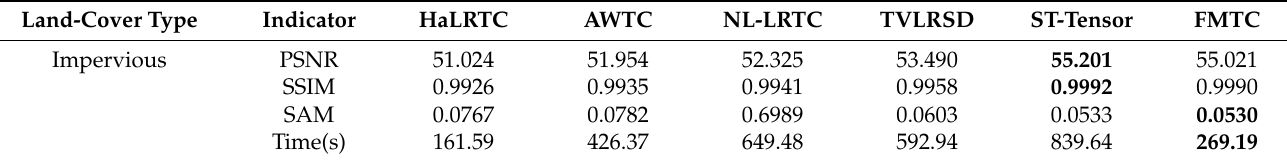
Figure 12. Enhanced details from Figure 11a–h: ( a ) original image; ( b ) simulated cloudy image; ( c – h ) reconstructed images of HaLRTC, AWTC, NL-LRTC, TVLRSD, ST-Tensor and FMTC algorithms, respectively. Table 3. Quantitative comparison of six algorithms applied to four land-cover